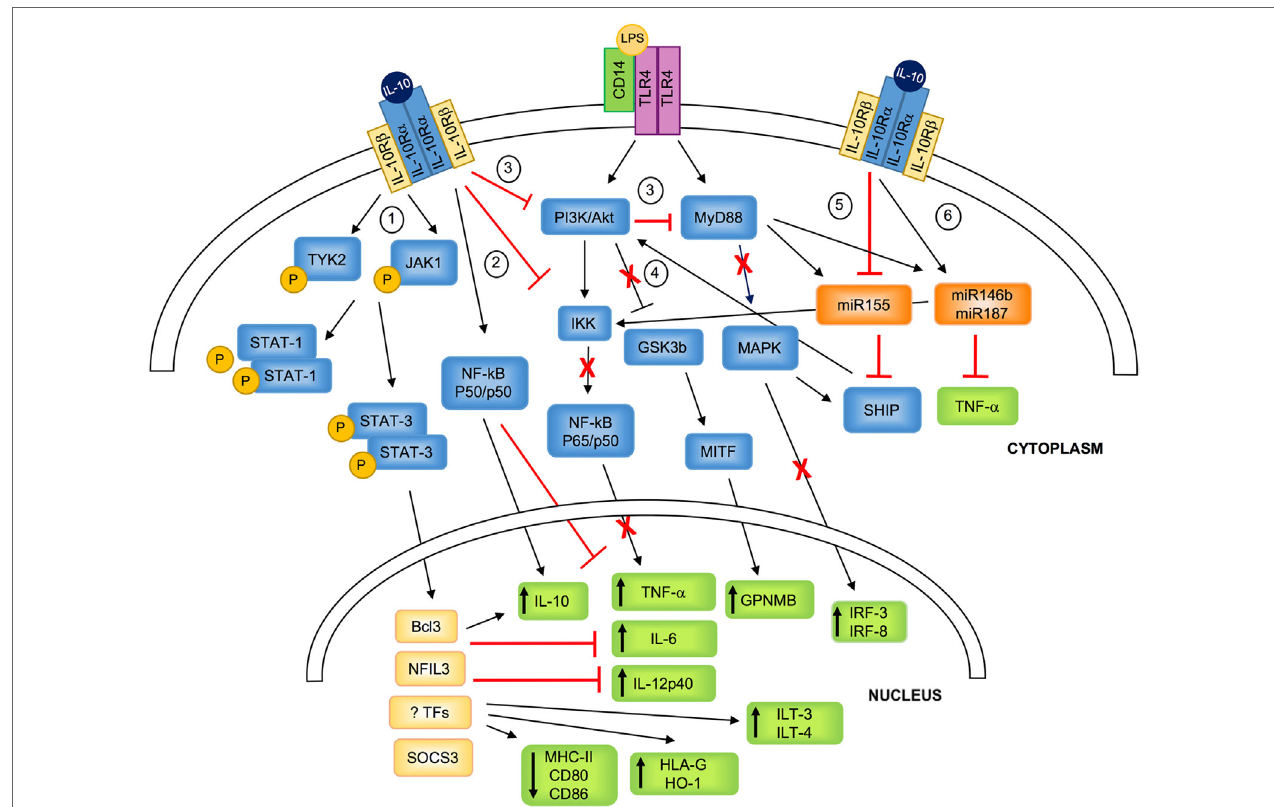
FigURe 1 | IL-10-mediated modulation of myeloid cells. IL-10 binds to a tetrameric receptor consisting of two IL-10R α and two IL-10R β subunits. 1. IL-10/IL-10R interaction leads to JAK1 and TYK2 phosphorylation and the consequent STAT3 and STAT1 phosphorylation. P-STATs, and in particular P-STAT3, dimerizes and translocates to the nucleus, where it promotes the transcription of specific molecules (i.e., SOCS3) or transcription factors (i.e., BCL3 and NFIL3), and inhibits the transport of MHC class II to the plasma membrane. 2. IL-10 signaling inhibits LPS-mediated activation of IKK that in turn prevents NF-kB-p65/p50 nuclear translocation and the expression of pro-inflammatory cytokine. In parallel, IL-10 promotes the selective NF-kB-p50/p50 nuclear translocation, which concurs in downregulating pro-inflammatory cytokine expression, and, in association with BCL3, promotes IL-10 expression. 3. IL-10 inhibits PI3K/Akt pathway that prevents LPS-mediated activation of MyD88, resulting in the inhibition of the expression of IRF-3 and IRF-8. 4. IL-10-mediated inhibition of PI3K/Akt pathway leads to GSK3 β and MITF activation, responsible for the upregulation of the transcription of GPNMB. 5. IL-10 downmodulates LPS-induced expression of miR155, which directly inhibits SHIP1 and favors the negative regulation of TLR4 signaling by counteracting PI3K activity. 6. IL-10 enhances LPS-mediated induction of miR146b and miR187, which post-transcriptionally regulate mRNA encoding for TNF- α and reduce IL-6 and IL-12p40 transcription via inhibition of the transcription factor IkB. TYK, tyrosine kinase; JAK, Janus kinase; PI3K, phosphoinositide 3-kinase; Akt, protein kinase B; MyD88, myeloid differentiation primary response 88; STAT, signal transducer and activator of transcription; IKK, IkB kinase; NF-kB, nuclear factor kappa-light-chain-enhancer of activated B cells; GSK3 β , glycogen synthase kinase 3 beta; MITF, microphthalmia-associated transcription factor; MAPK, mitogen-activated protein kinase; SHIP1, SH-2 containing inositol 5 ′ polyphosphatase 1; Bcl3, B-cell lymphoma 3-encoded protein; NFIL3, nuclear factor interleukin 3; TFs, unknown transcription factors; SOCS, suppressor of cytokine signaling; GPNMB, glycoprotein NMB; HO-1, heme-oxygenase-1; ILT, immunoglobulin-like transcript; IRF, interferon regulatory factor; IL-10R, IL-10